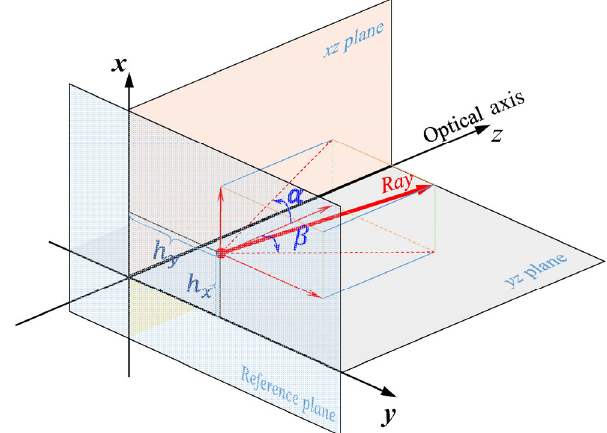
Fig. 3 Description of a ray.